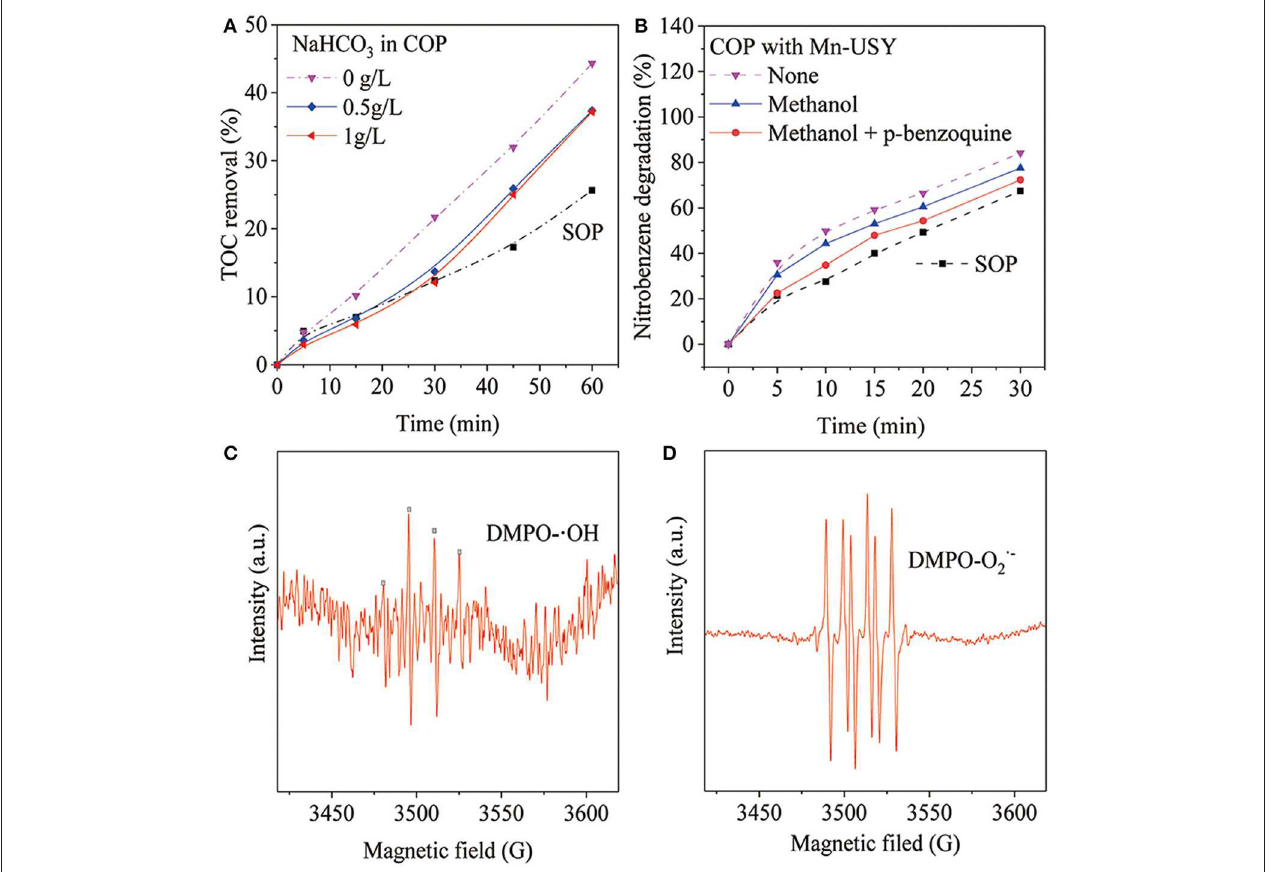
FIGURE 7 | TOC reduction after COP treatment (60min) using Mn-USY with the addition of NaHCO 3 (A) , methanol (5mg · L − 1 ) and p-benzoquinone (5mg · L − 1 ) (B) , liquid-phase ESR spectra of · OHs (C) and O 2 ·− (D) with DMPO spin trapping.